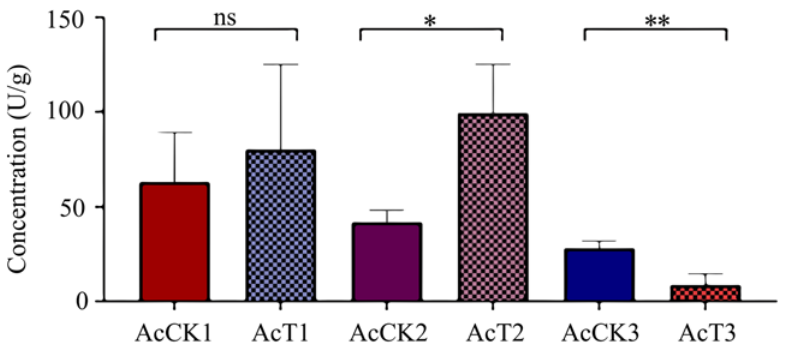
Figure 6. PPO activity in A. cerana 4-, 5-, and 6-day-old larval guts infected by A. apis . The experimental data are shown as mean ± SD and were subjected to Student’s t -tests, ns: p > 0.05, *: p < 0.05, **: p < 0.01. AcCK1, AcCK2, and AcCK3 respectively represent the uninfected 4-, 5-, and 6-day-old larval guts, whereas AcT1, AcT2, and AcT3 respectively represent the A. apis – infected 4-, 5-, and 6-day-old larval guts.